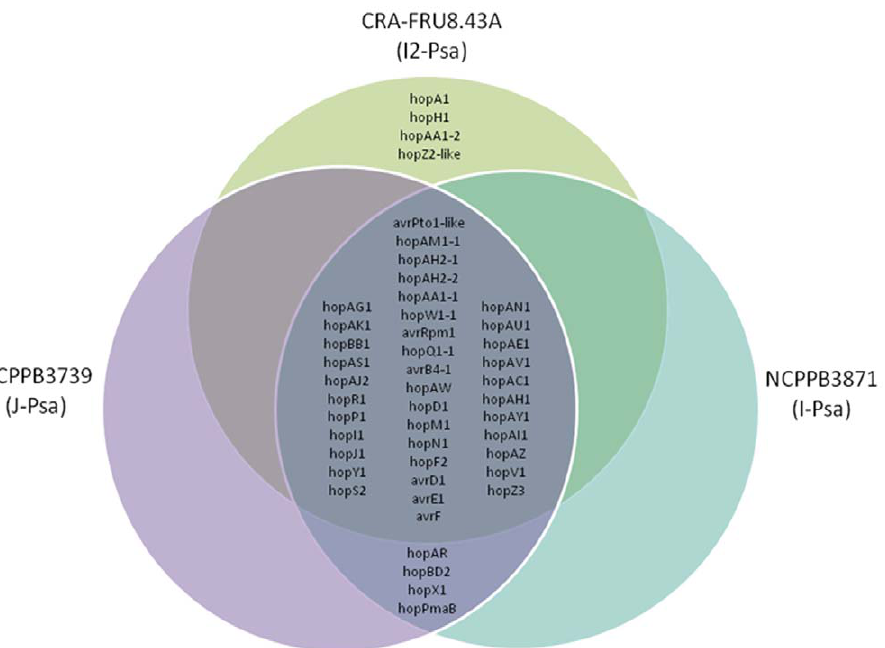
Figure 6. Venn diagram of the type III effector gene complements of J- Psa , I- Psa and I2- Psa strains based on the comparison of the same complement of other sequenced plant pathogenic pseudomonads. The genes conserved among the three strains are indicated in the middle of the diagram. J-Psa and I-Psa as well as I2-Psa display four unique different effector genes (see also Table S3).